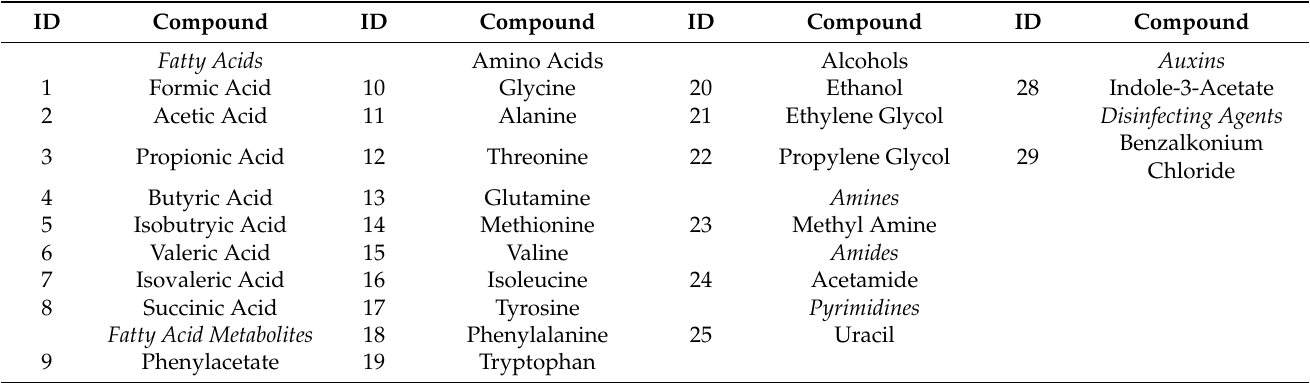
Figure 5. 1 H- 1 H TOCSY NMR spectra of the functionalized alkyl and alkyl regions of microcosm samples after 18 days of BAC exposure. ( a ) 0 mg/L BAC, ( b ) 16.7 mg/L BAC, ( c ) 33.3 mg/L, ( d ) 66.7 mg/L BAC. Colors denote different classes of compounds; BAC (red), linear fatty acids (green); branched chain fatty acids (blue); amino acids (purple); alcohols (orange). Table 1. Metabolites identified in microcosm studies using 1 H NMR